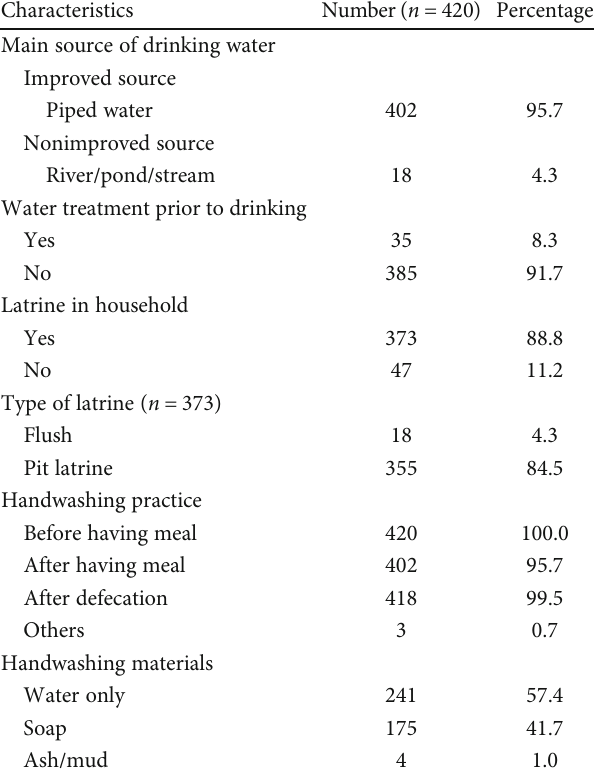
Table 2: Household water- and sanitation-related characteristics of the study population.